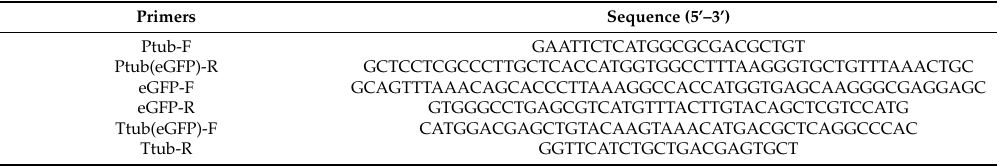
Table 3. Primers prepared for the construction of pSimple- tub-eGFP via fusion